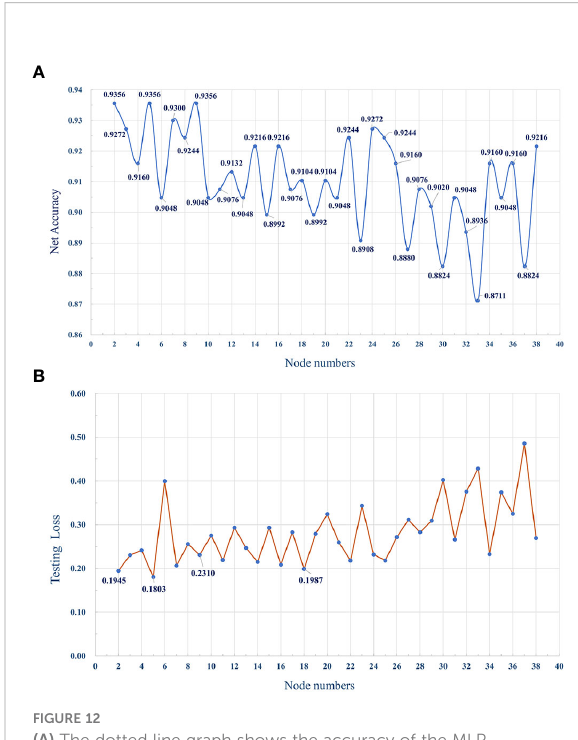
FIGURE 12 (A) The dotted line graph shows the accuracy of the MLP classi fi er, with different number of nodes in the hidden layer. (B) The average loss of the model with different numbers of hidden layer nodes during